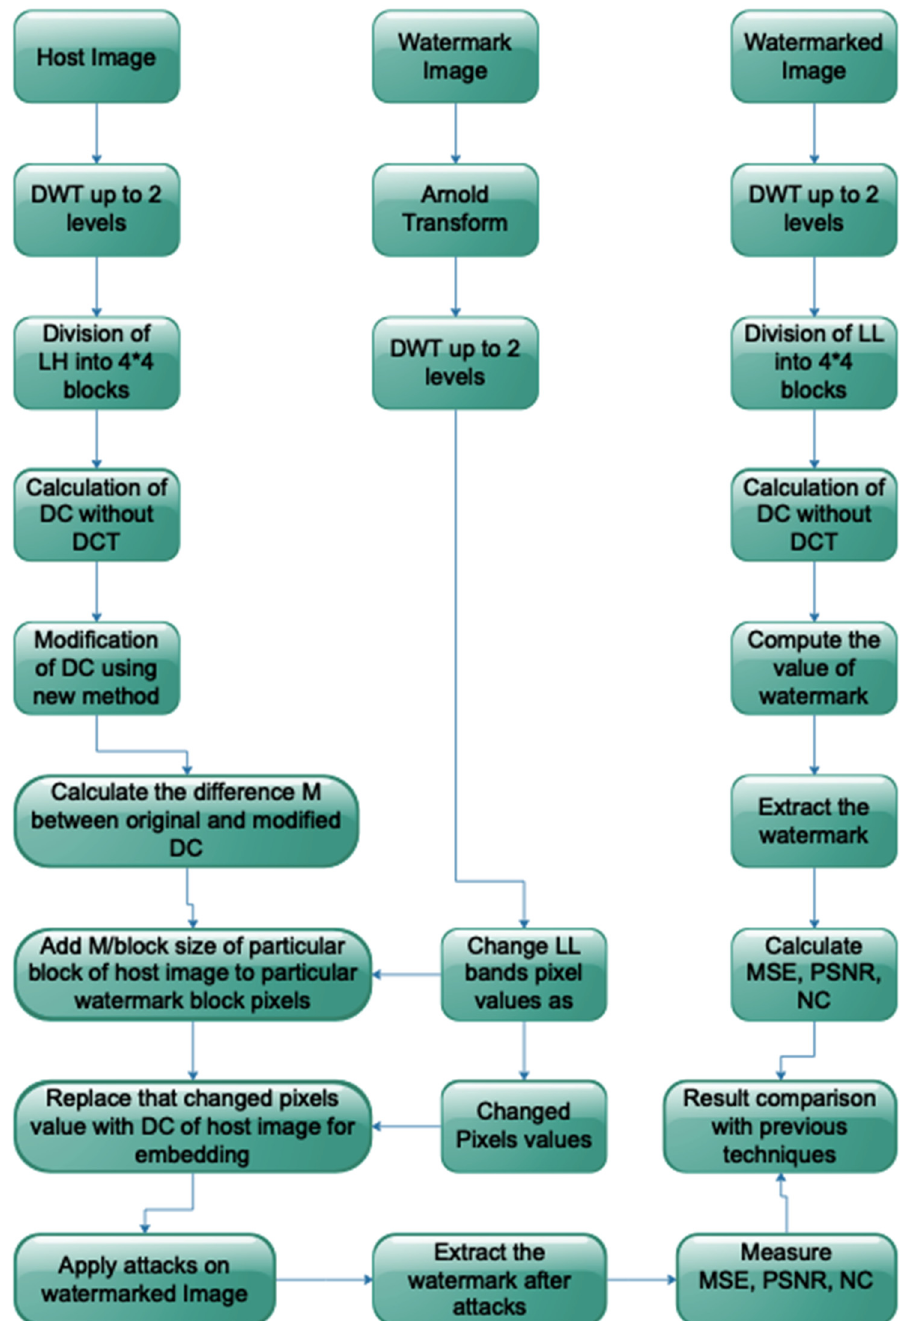
Figure 7. Proposed embedding, extraction algorithms, attacks, and result